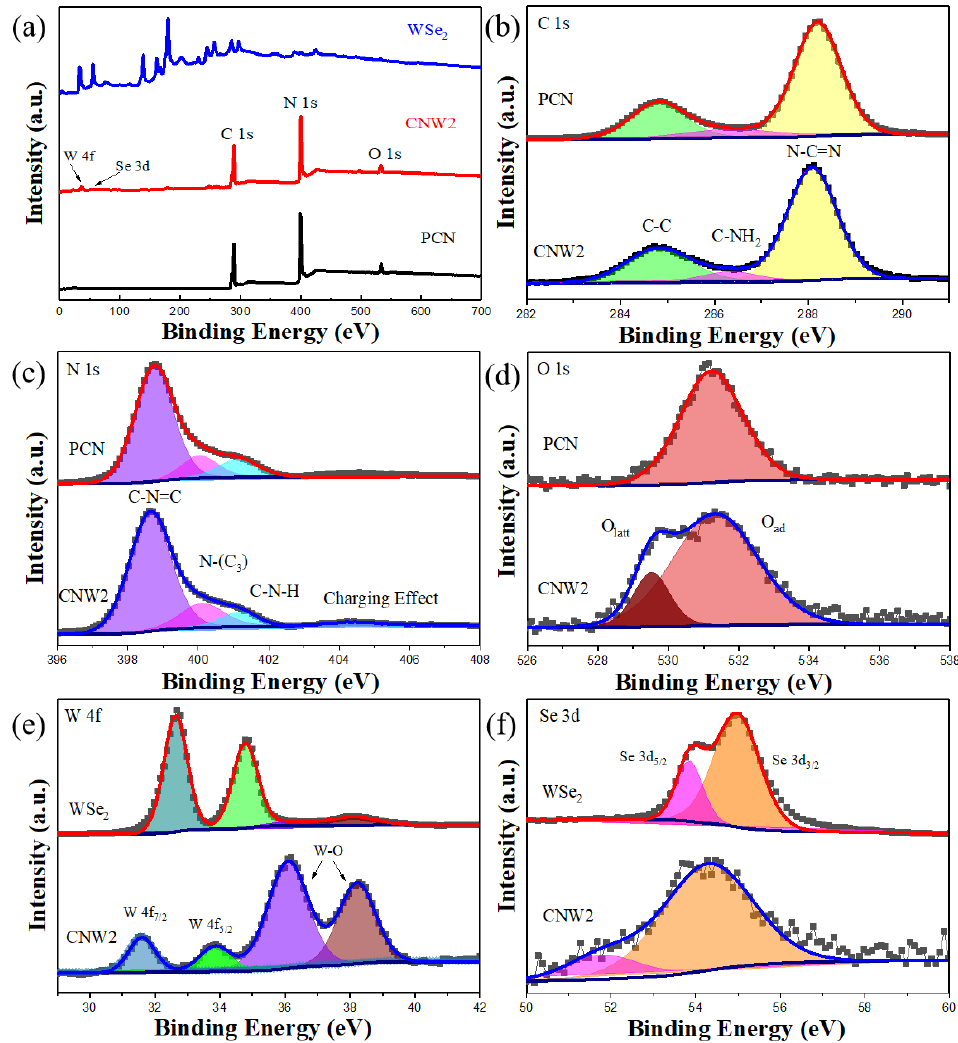
Figure 4. ( a ) XPS survey spectra of WSe 2 , CNW2, and PCN, ( b ) High-resolution XPS C 1s spectra of CNW2 and PCN, ( c ) N 1s spectra of CNW2 and PCN, ( d ) O 1s spectra of CNW2 and PCN, ( e ) W 4f spectra of WSe 2 and CNW2, and ( f ) Se 3d spectra of WSe 2 and CNW2.